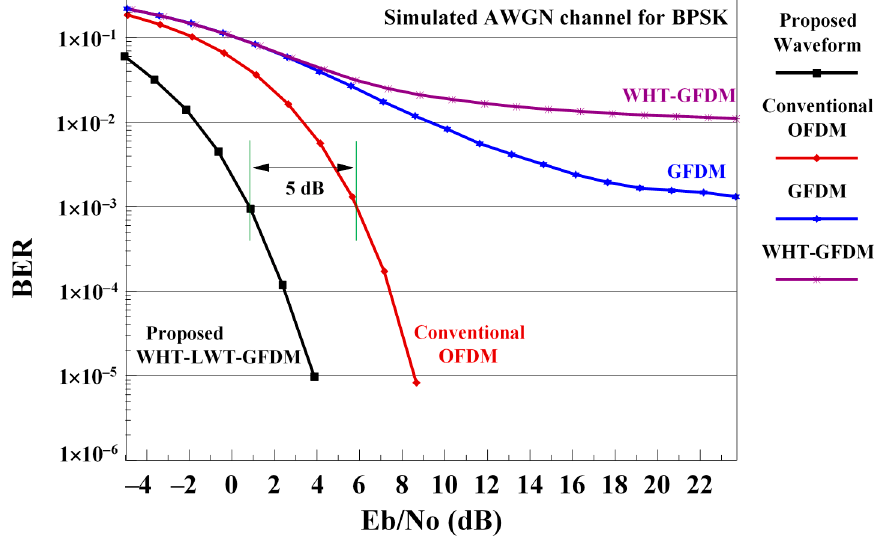
Figure 6. Comparison of traditional OFDM, GFDM, WHT-LWT-GFDM, and proposed WHT-LWT-GFDM waveforms performance on AWGN channel.